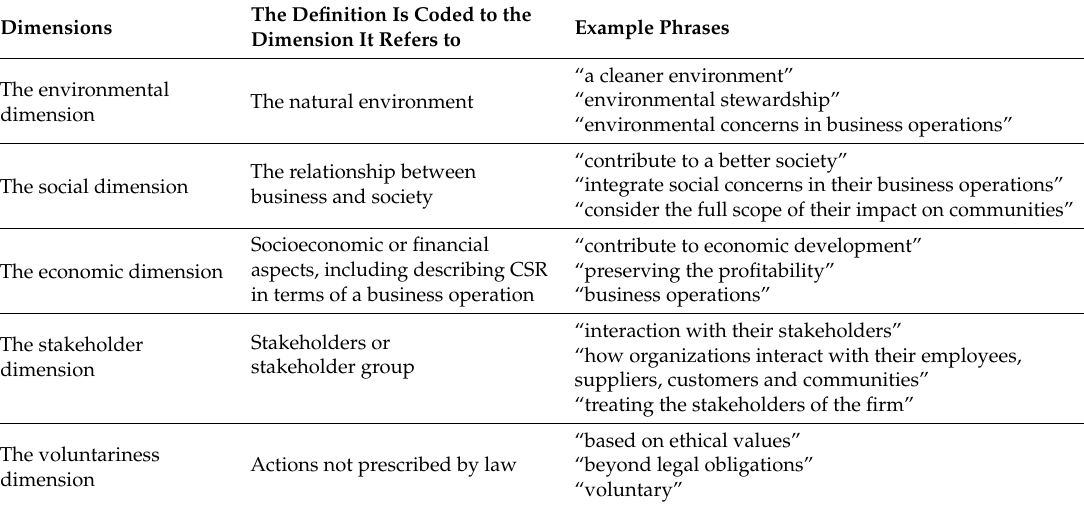
Table 1. The five dimensions of CSR coming from Dahlsrud [18].